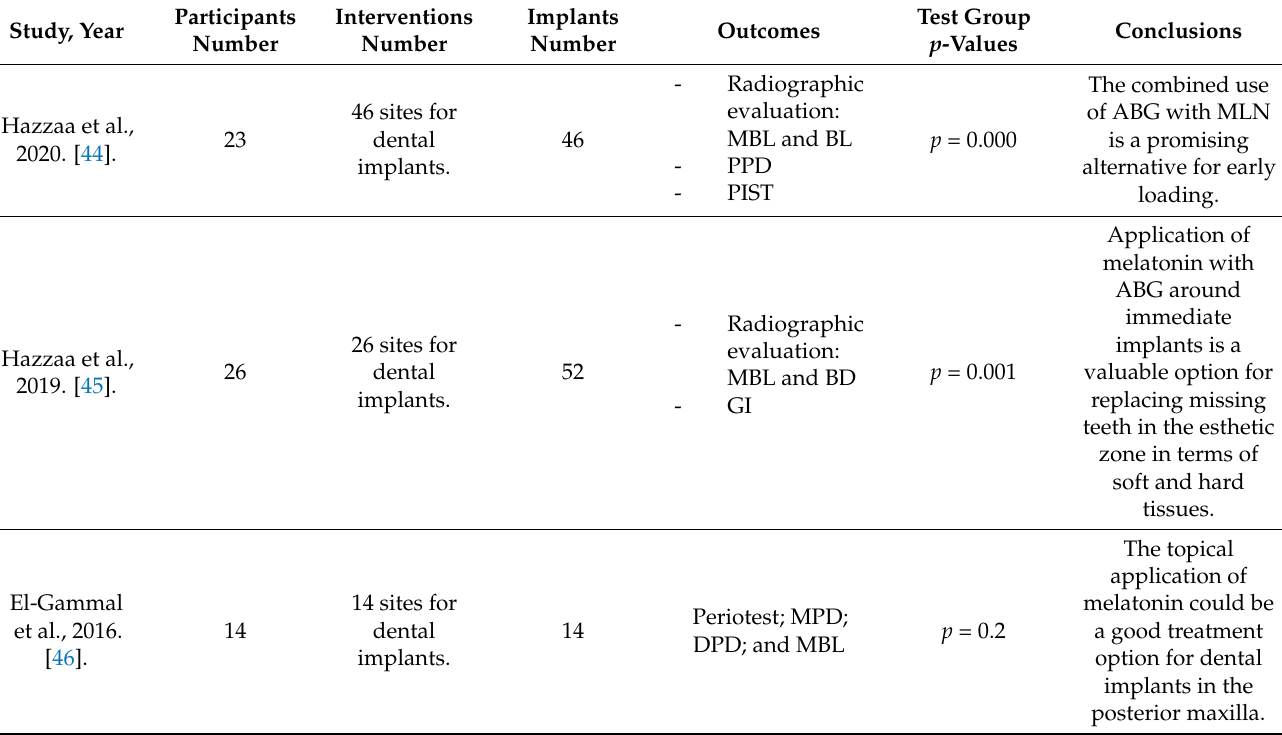
Table 2. Characteristics of randomized clinical trials (RCTs).